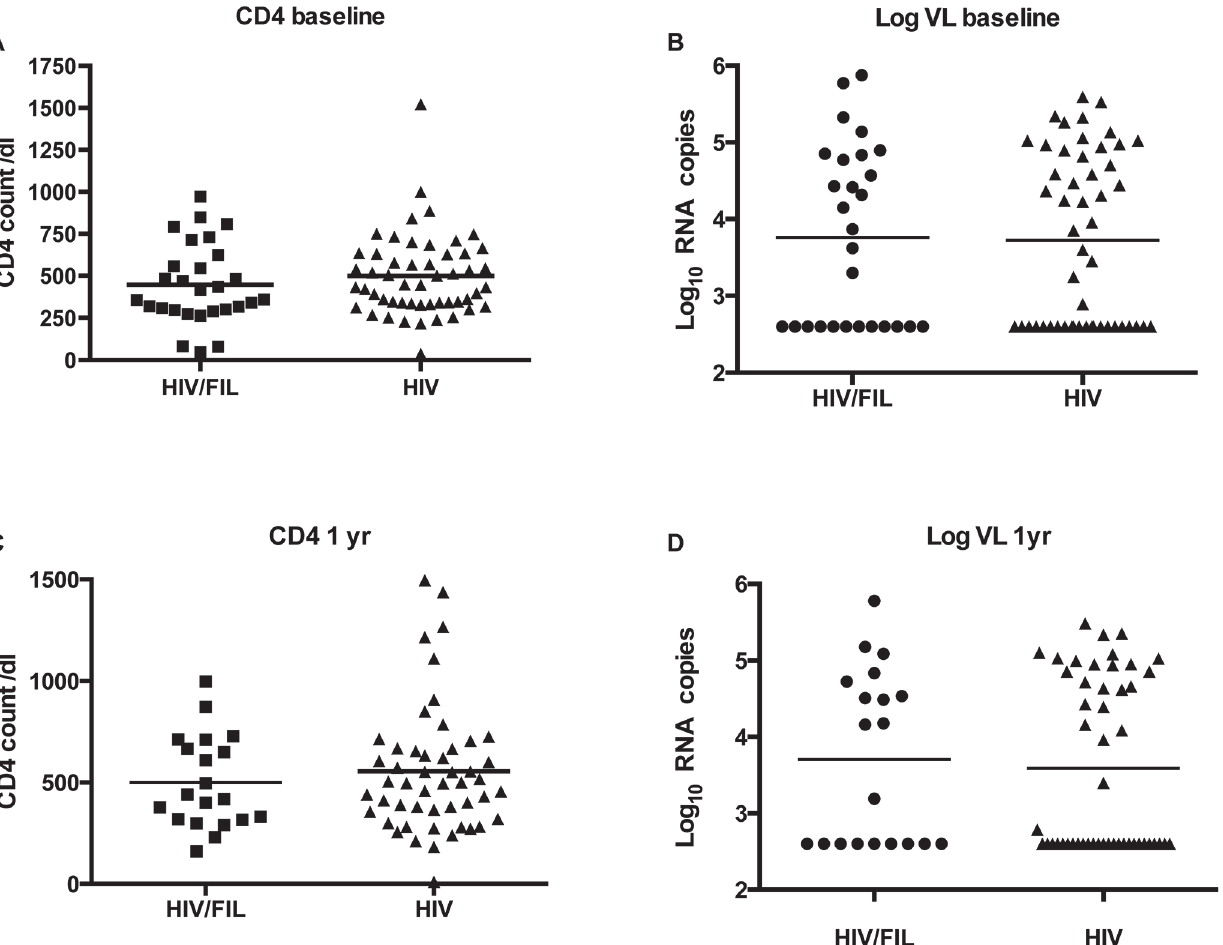
Fig 2. CD4 count and viral load comparisons at baseline and 1 year. Comparison of CD4 and viral load (VL) at baseline ( A CD4 [count/dL]), B log VL [log 10 RNA Copies]) and at 1 year ( C CD4 count, D log VL) between HIV+/FIL+ cases and HIV+/FIL- controls.